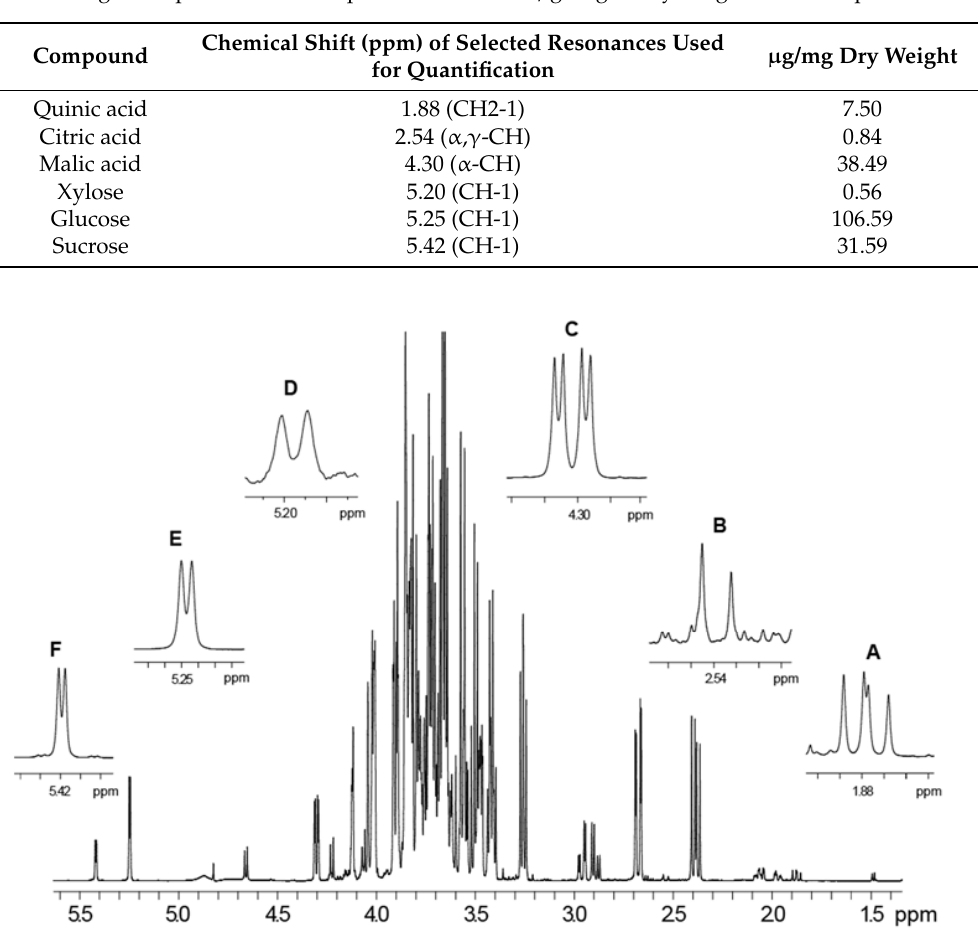
Table 5. Compounds identified in the 1 H NMR spectrum of P. domestica subsp. syriaca fruit pulp extract dissolved in phosphate buffer/D2O and the corresponding chemical shift signals (ppm) used in the integration process. The compound amounts in µ g/mg of dry weight are also reported.